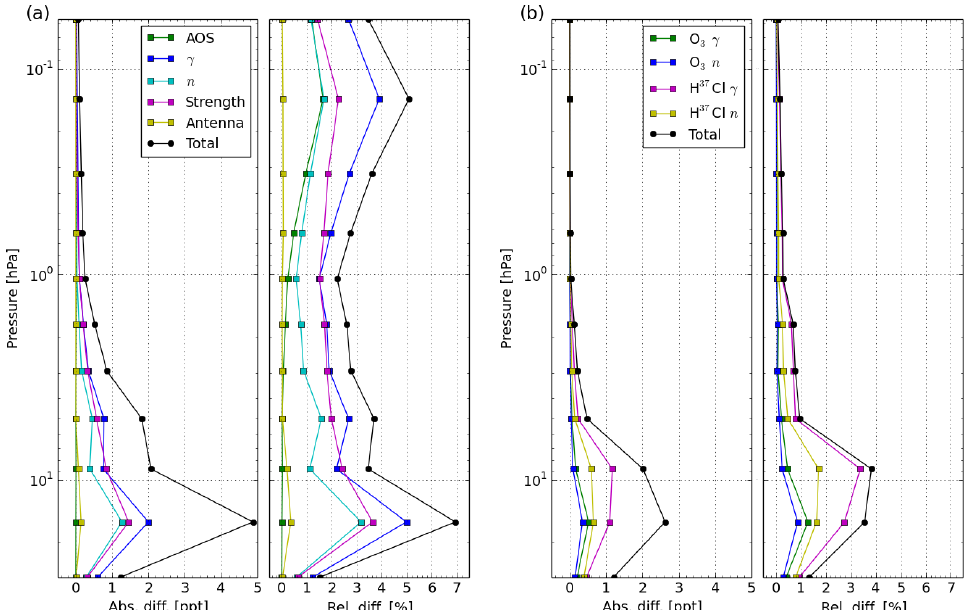
Figure 4. (a) Summary of absolute and relative differences derived from systematic errors of CH 3 CN retrieval caused by uncertainties in the spectral parameters and (b) instrumental functions derived from a single-scan spectrum observed on 4 November 2009 in the tropics, as shown in Fig. 3. The black line indicates the total error calculated by the root sum square of all assumed error sources.